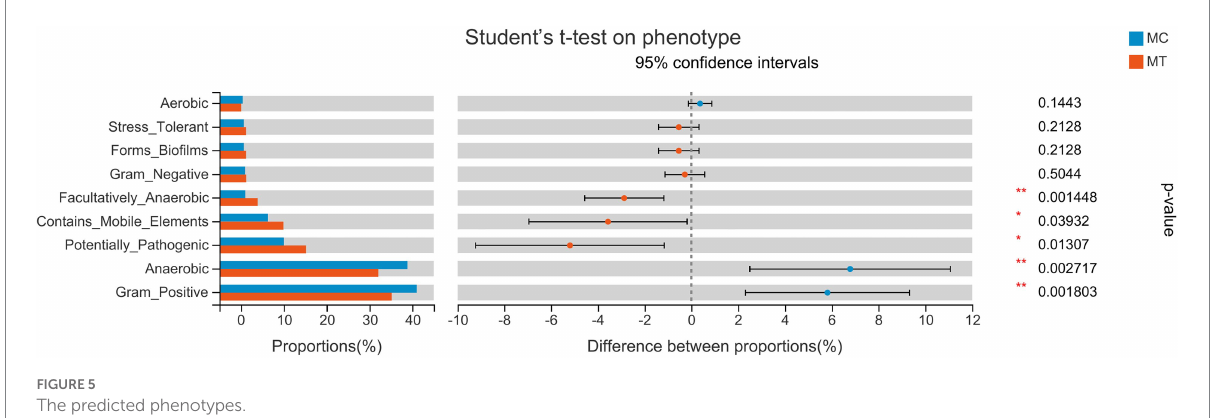
FIGURE 5 The predicted